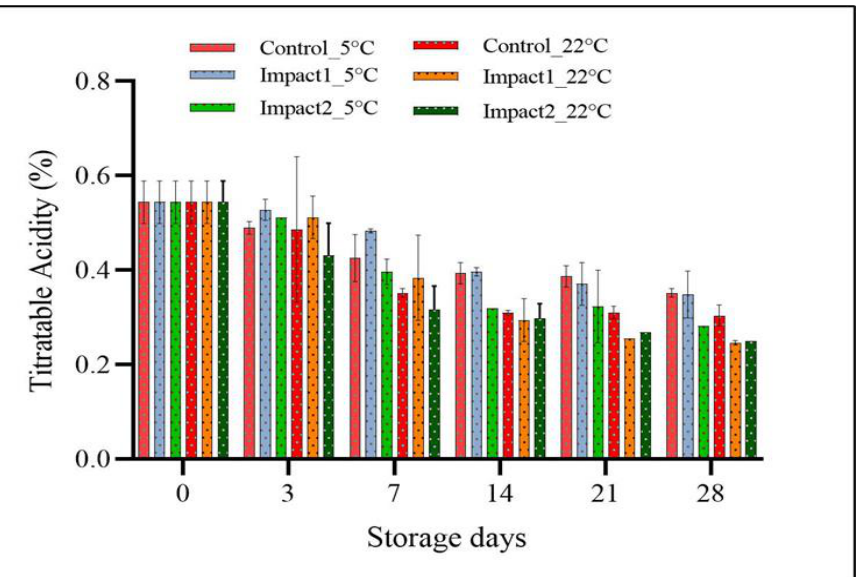
Figure 4. Titratable acidity ( TA% ) of non-bruised, low-impact (45°; 1.18 J), and high-impact (65°; 2.29 J) bruised fruit over 28 days of storage at 5 °C and 22 °C. Error bars represent the SD of the mean values of six readings per group (treatment). Table 2. Sugar:acid ratio ( TSS:TA ), BrimA , and pH of non-bruised, low-impact (45 ◦ ; 1.18 J), and high-impact (65 ◦ ; 2.29 J) bruised pomegranate fruit over 28 days of storage at 5 ◦ C and 22 ◦ C. The values are presented as standard deviation (SD) of the mean values of six readings per two replicates of each group